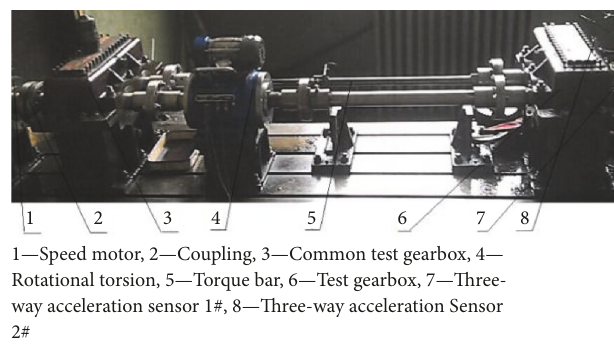
Figure 15: The result obtained by VMD.